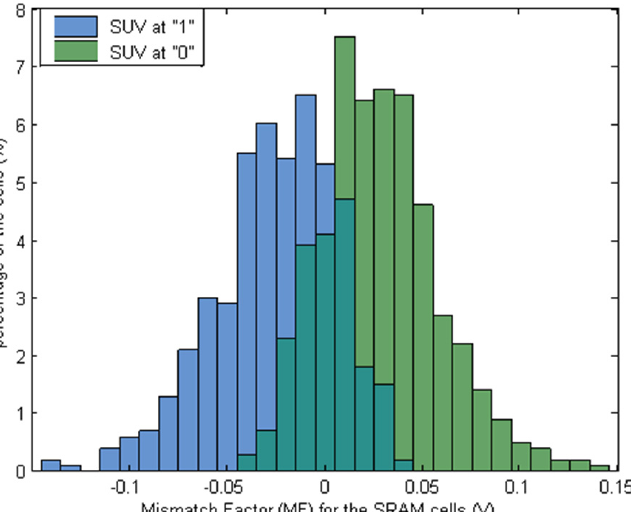
Figure 4. Mismatch factor histograms depicting the SUV in different colors. The unpredictable memory cells obtained with 65 nm CMOS 6T-SRAM can be observed by the overlap of histograms, which are all close to MF = ‘0’.